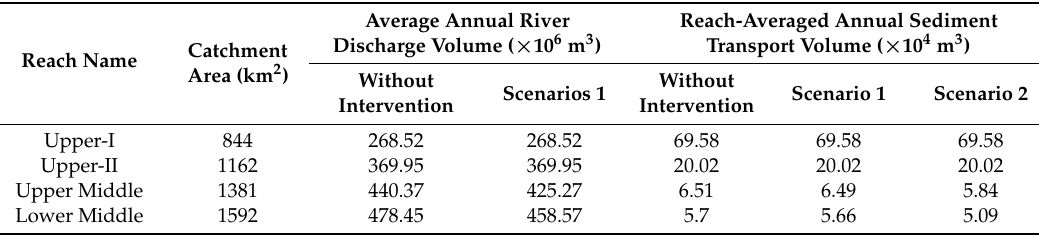
Table 3. Average annual river discharge volume and calculated reach-averaged annual sediment transport capacity without and with interventions represented by Scenarios 1 and 2.